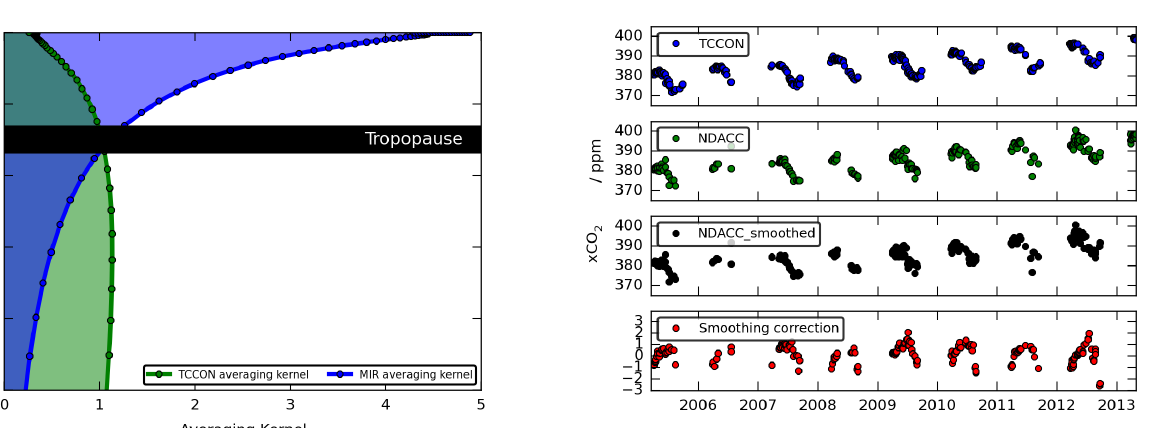
Figure 7. Visualization of the tropospheric and stratospheric contri- bution of the MIR (blue) and TCCON (green) averaging kernels for an example solar zenith angle of 69 ◦ .